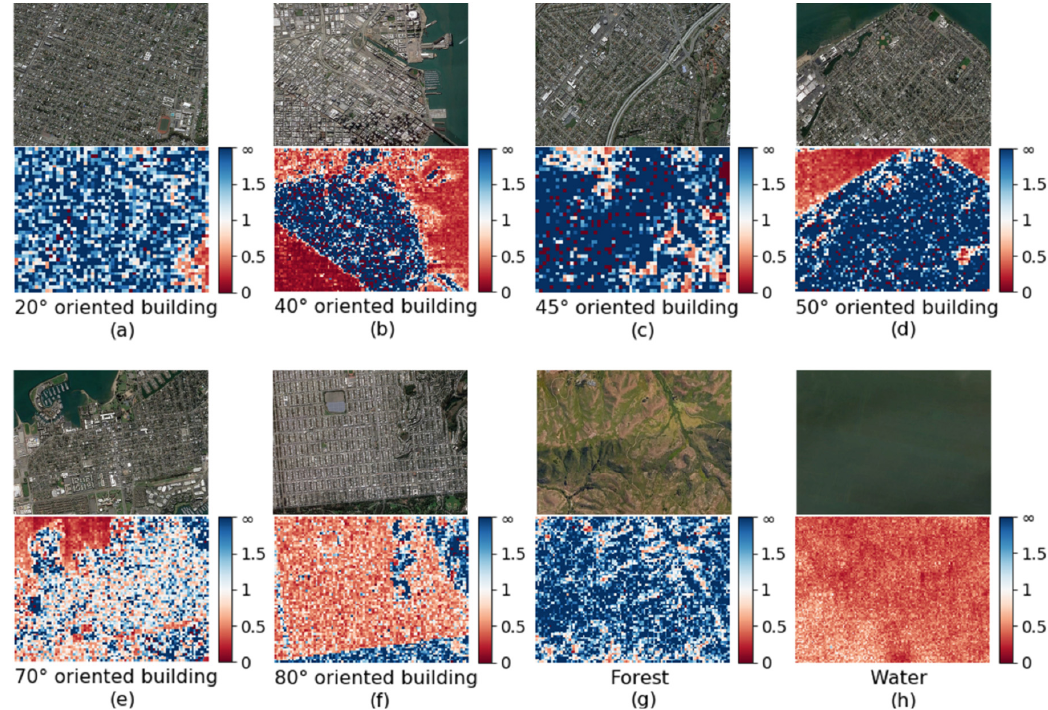
Figure 11. The determined value of aggregation parameter γ in building samples over San Francisco, USA. To further analyze the physical meaning of γ , we selected more PolSAR data from an RADARSAT-2 C-band image over San Francisco to compare the performance of γ be- tween different land-uses. As shown in Figure 12a, the golf course, ocean, and different oriented buildings could be distinguished by values of γ with different colors. The rectan- gle box with white border in Figure 11a represents the selected samples of 5°, 30°, 30°, and 45° oriented buildings; the golf course; and the ocean. Figure 12a shows the statistical re- sults of the samples, indicating that it was easier to fit a high value of γ with a higher mean